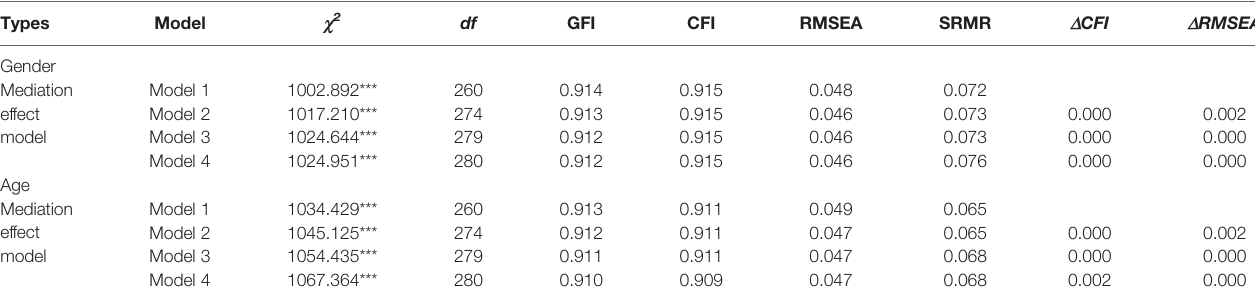
TABLE 3 | Tests of structural